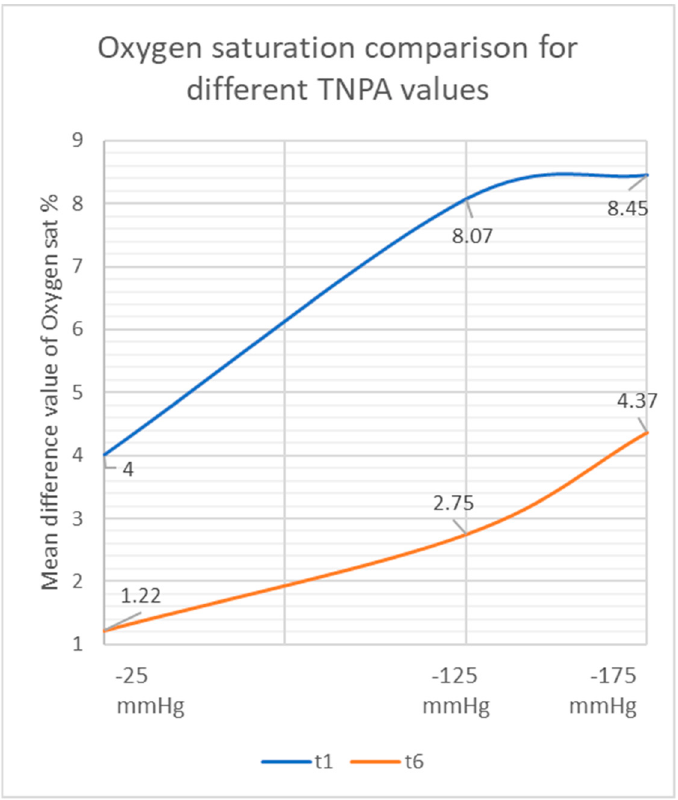
Figure 10. Correlation between the means resulting from different TNP values at t1 and t6.